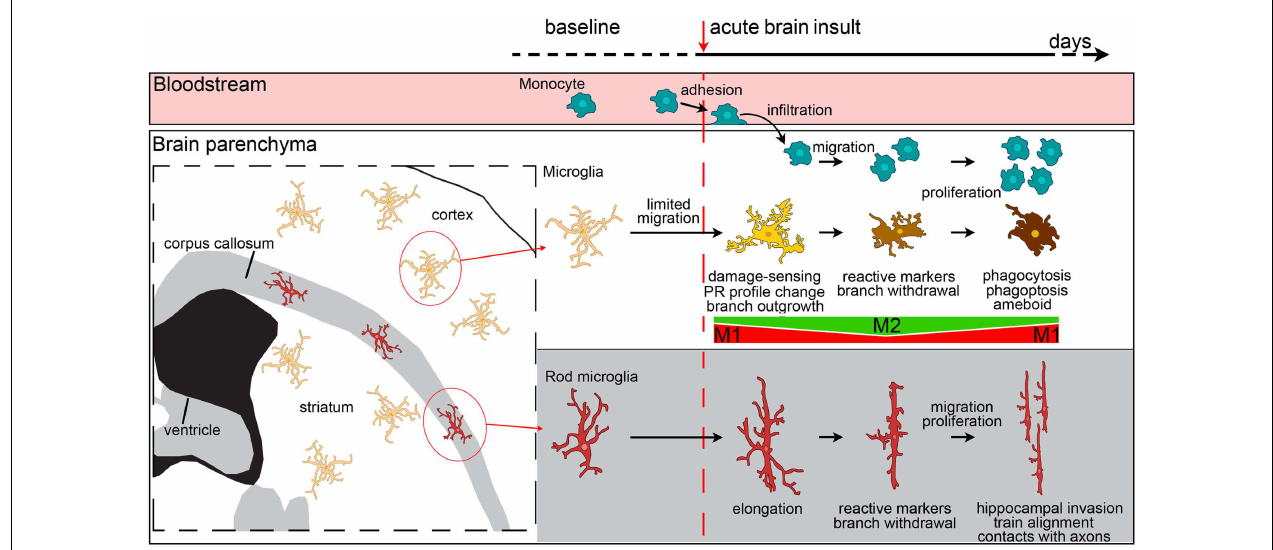
populations upregulate M2 markers.The peak of M2 marker expression soon vanishes and is followed by upregulation of M1 markers that lasts longer. In vivo , mixed polarization phenotypes are observed and the M1-M2 definition may only serve to set the extremes of a continuum of polarization states. Macrophages from blood-borne monocytes seem to be more able to express M2 markers than microglia. In the white matter, rod microglia activate after injury by enhancing their elongated morphology, expressing reactive markers (CD68, MHCII), and migrating to other areas, such as the hippocampus. Rod microglia also cluster into trains of cells that align to neuronal axons. Neither the exact phenotype profile nor the functions of activated rod microglia are fully understood, though a role of these cells in synaptic stripping due to their contacts with axons has been